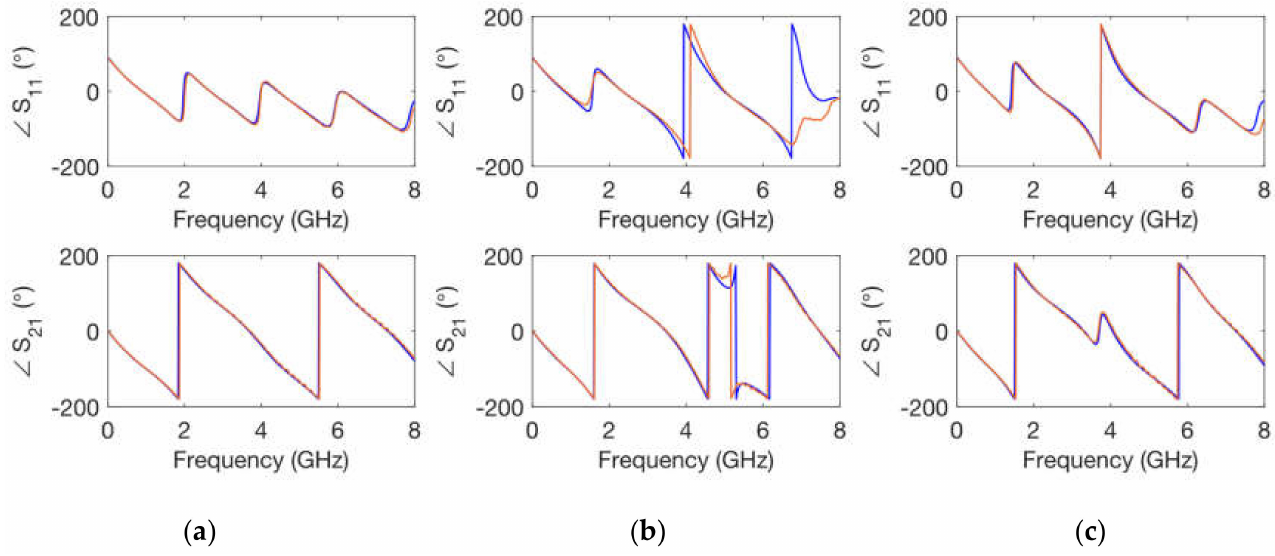
Figure 9. Simulated ( blue ) and measured ( orange ) calibrating elements phase of scattering parame- ters for a h = 1.6 mm substrate height. ( a ) transmission line; ( b ) short stub; ( c ) long